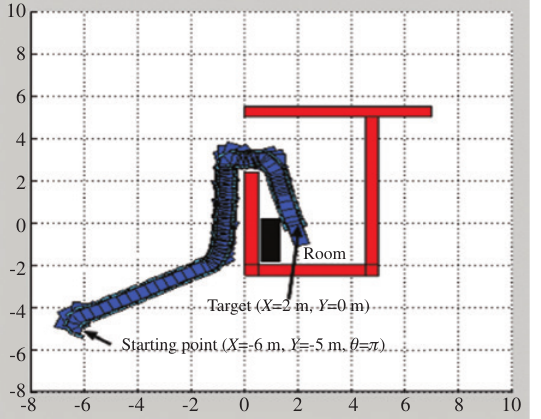
Figure 11: Navigation and Obstacle